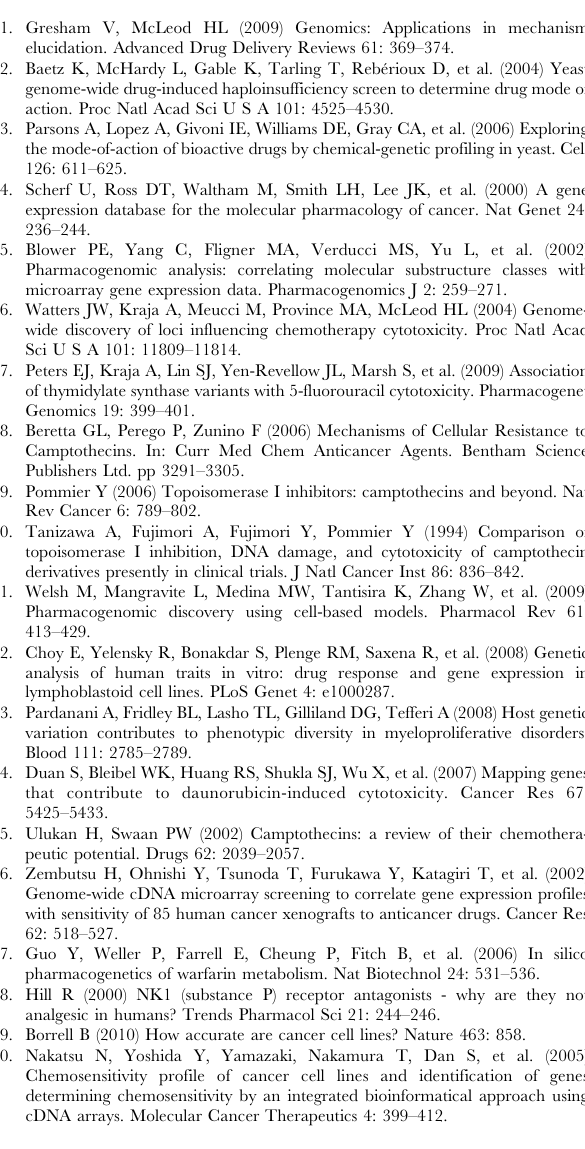
Dataset S3 Boxplots illustrating variance in cell viability across the entire CEPH population (n=125) for each drug. Line represents mean phenotypic response, whiskers box represents upper and lower quartiles, and whiskers are 1.5*IQR. Outliers